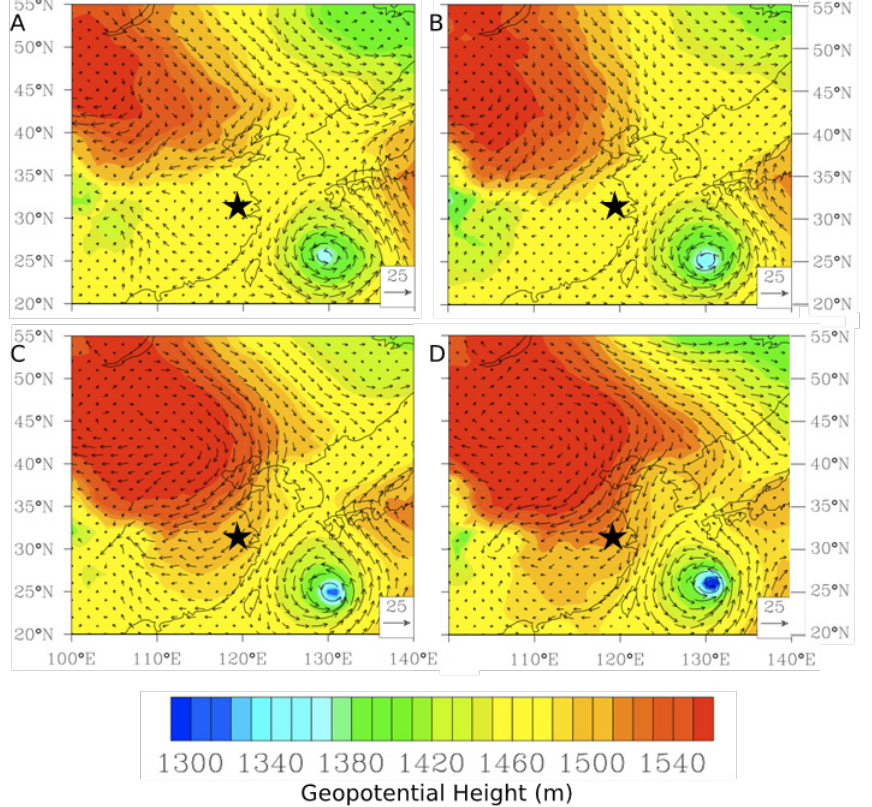
Figure 6. Geopotential height maps over East Asia at the 850 hPa level from NCEP/NCAR reanalysis data. The dates and times are ( A ) 16 September 2011 18:00 UT, ( B ) 17 September 2011, 06:00 UT, ( C ) 17 September 2011, 18:00 UT, ( D ) 18 September 2011, 18:00 UT. The star (  ) indicates the location of